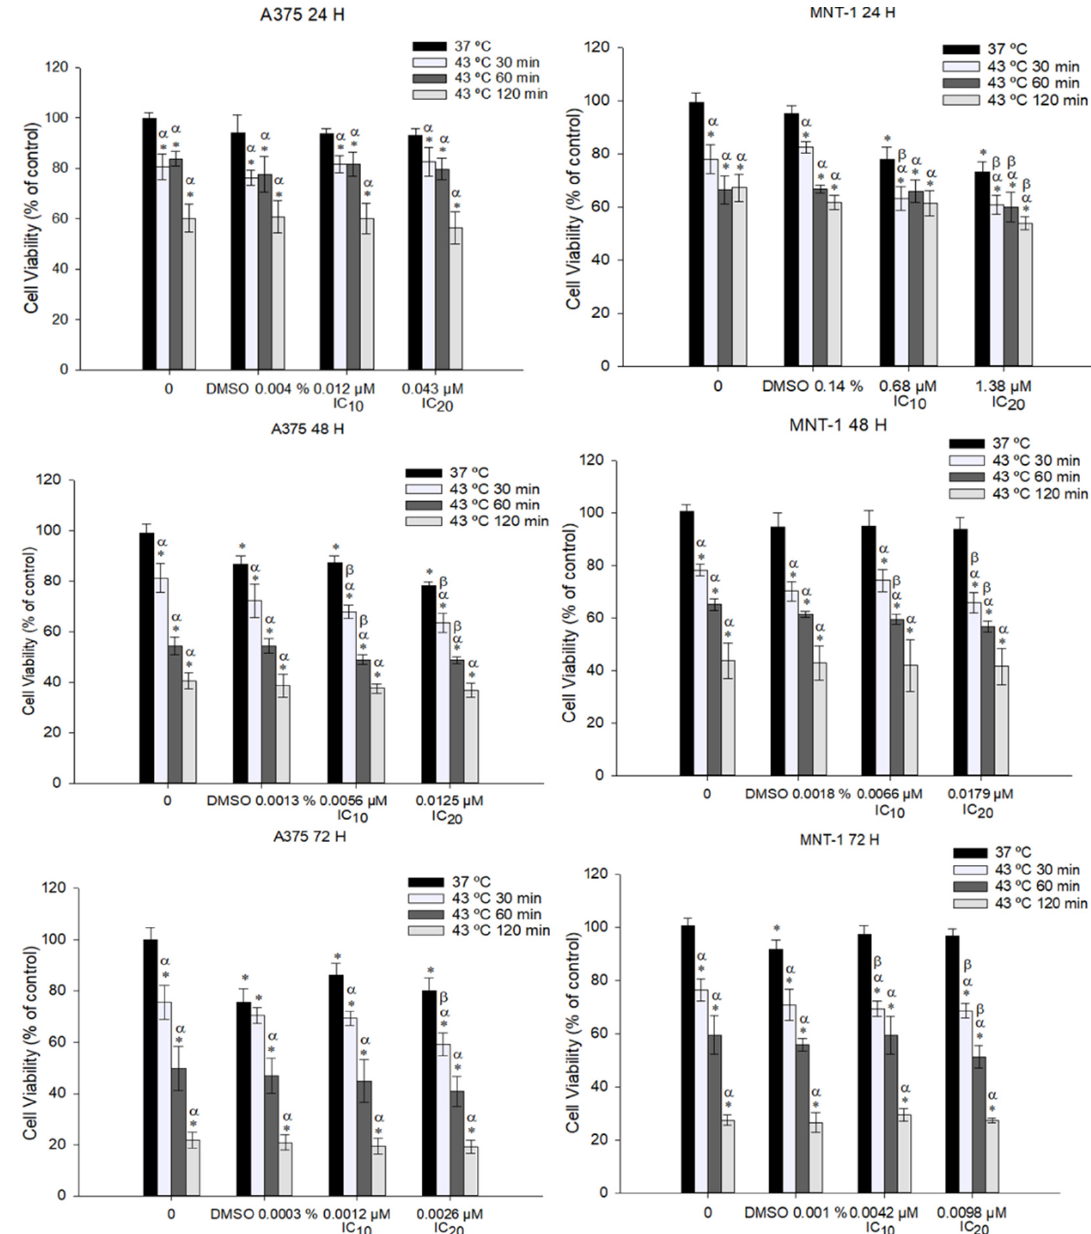
Figure 2. Effect of hyperthermia plus DOX on cell viability of A375 and MNT-1 cells. Cells were exposed to 43 ◦ C for 30, 60, or 120 min, plus 0.012 µ M or 0.043 µ M and 0.68 µ M or 1.38 µ M during 24 h; 0.0056 µ M or 0.0125 µ M and 0.0066 µ M or 0.0179 µ M during 48 h; and 0.0012 µ M or 0.0026 µ M and 0.0042 µ M or 0.0098 µ M during 72 h; in cases of A375 or MNT-1, respectively. DMSO concentrations correspond to the equivalent percentage present in IC 20 of each cell line and time exposure. DOX concentrations correspond to the calculated IC 10 and IC 20 for each time exposure and for each cell line. Cell viability was determined using MTT assay. Data are shown as mean ± standard deviation of two independent experiments with four technical replicates each. *—indicates statistical significance in comparison to the control 37 ◦ C; α indicates statistical significance in comparison to the respective control of each condition at 37 ◦ C; and β indicates statistical significance of the combined treatment in comparison to hyperthermia alone ( p <